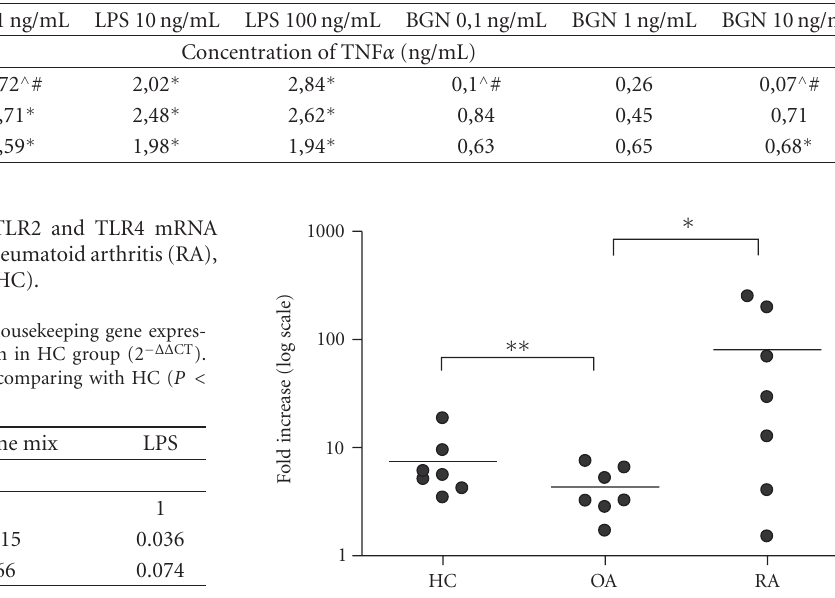
Table 3: Spontaneous and stimulated TNF α production by peripheral blood mononuclear cells from patients with rheumatoid arthritis (RA), osteoarthrosis (OA), and healthy control (HC); P < . 05 ∗ —significantly di ff erent from nonstimulated; #—significant di ff erence between RA and HC ∧ —significant di ff erence between RA and OA.